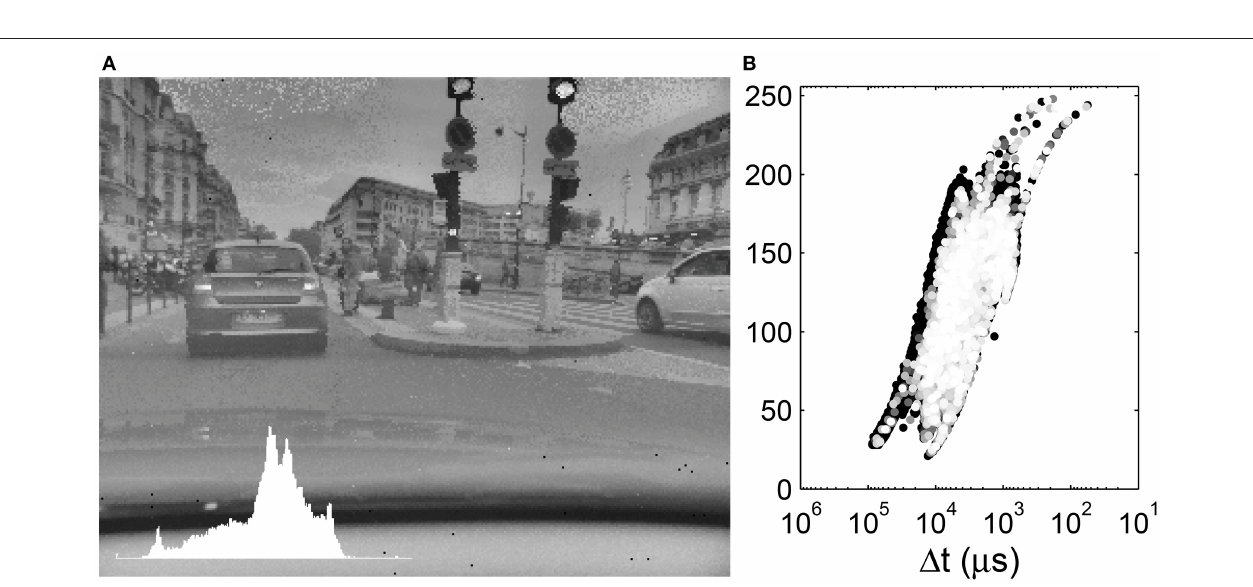
FIGURE 7 | (A) Local tone mapping with R = 30. Inset: Image histogram. (B) Display values as a function of the input time differences. The input time differences are plotted on an inverse logarithmic scale while the output gray-levels are plotted linearly. The 10% most recent events are colored with a gray-level.